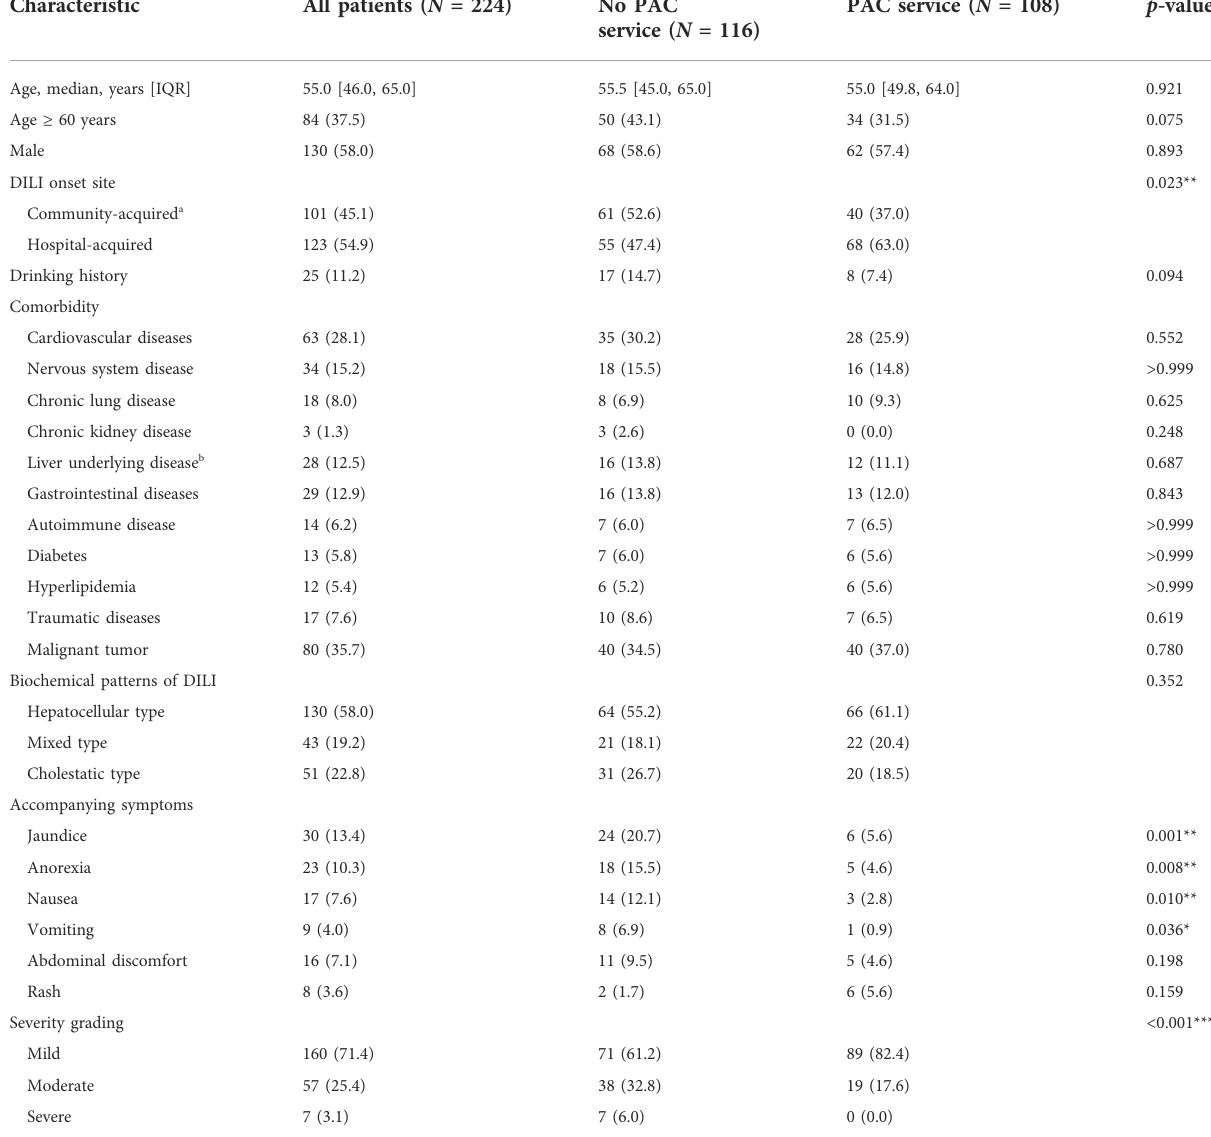
TABLE 1 Patient baseline and drug-induced liver injury clinical characteristics.